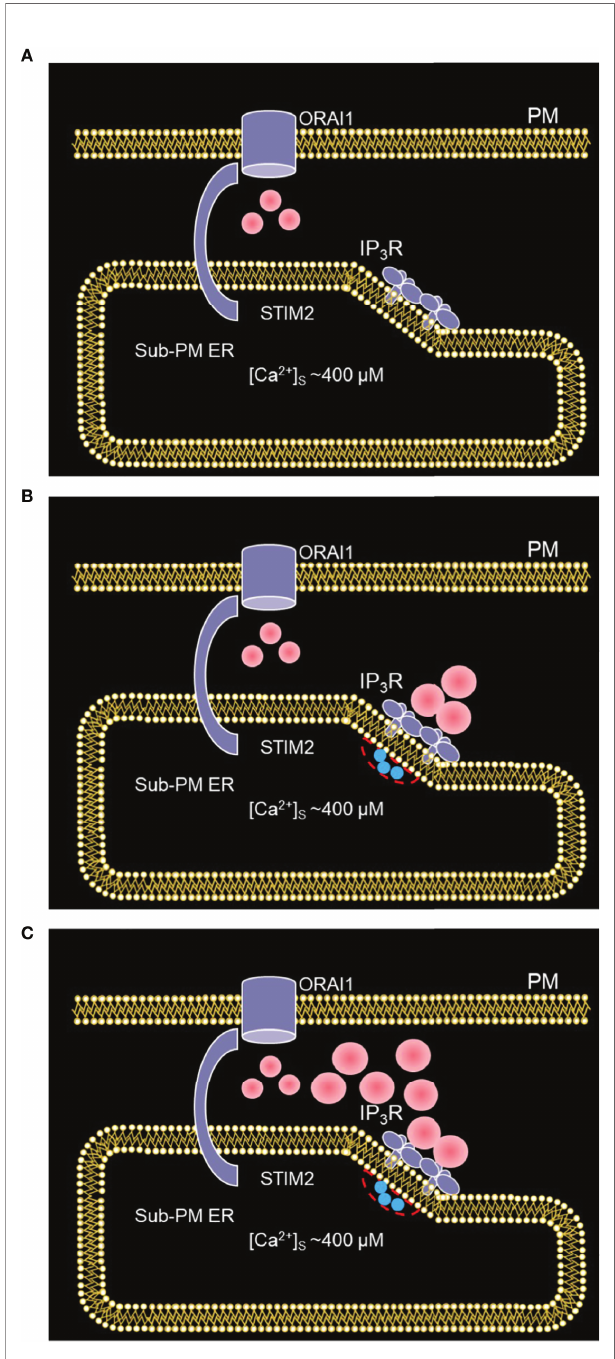
FIGURE 10 | Schematized representation of the proposed mechanism underlying the spontaneous formation of Ca 2+ microdomains in T cells. (A) The smallest microdomains arise from nano-scale [Ca 2+ ] fl uctuations in the sub-PM ER leading to the opening of ORAI1 channels STIM2 inherently co-localized with STIM2. (B) Following a short, spontaneous activation of one or a few IP 3 Rs close to the junction, Ca 2+ is released from the sub-PM ER into the cytosol. (C) The resulting local Ca 2+ depletion close to the IP 3 R ’ s mouth provokes the unbinding of Ca 2+ from STIM2, which further activates ORAI1 channels. This results in larger Ca 2+ signals in the microdomains. Red spots represent Ca 2+ ions.